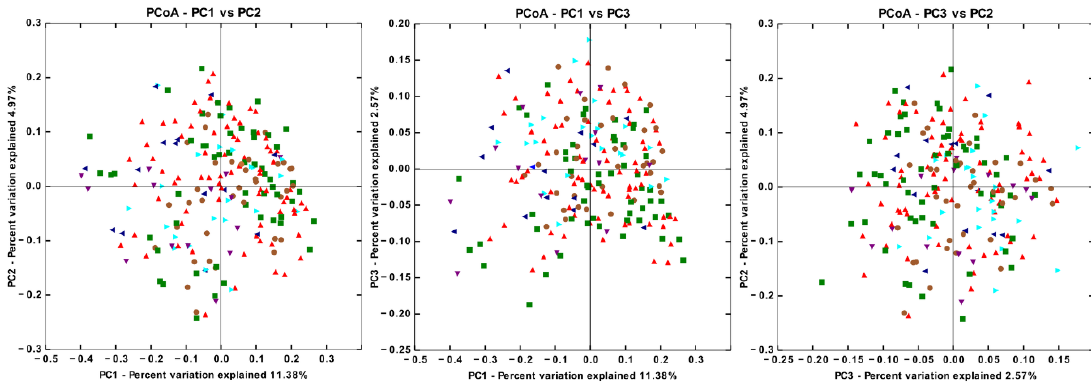
Figure 3. Bacterial beta diversity. Principal Coordinates Analysis based on unweighted UniFrac distances between the gut microbiota profiles of individuals from the six groups. Control (CO) red triangles, Prediabetes (PRE) green squares, T2D no medicated (T2D−No−M) dark blue triangles, T2D with Metformin (T2D−M) purple triangles, T2D with polypharmacy (T2D−P) light blue triangles, and T2D with polypharmacy + insulin (T2D−P+I) brown circles (see Table S4).